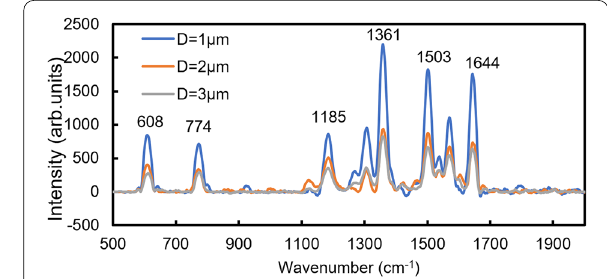
Figure 24 R6G Raman spectra of Au-Al ordered micro/nanostructure substrate obtained by indentation arrays with different spacing